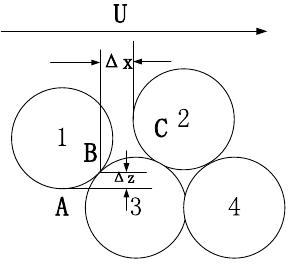
Figure 1. The schematic diagram of